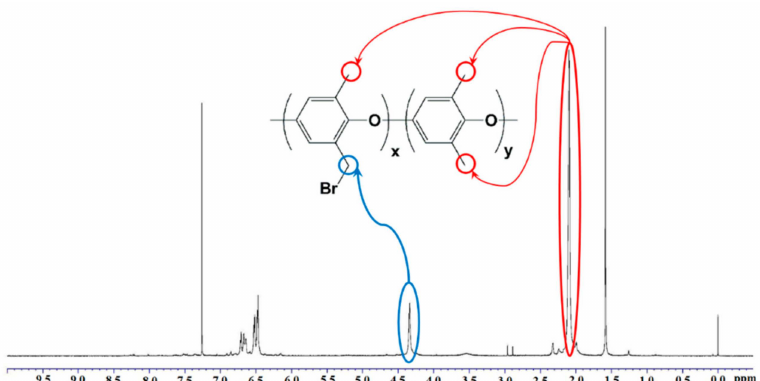
Figure 2. 1 HNMR spectra of BrPPO in CDCl 3 . The blue line indicates the characteristic peak of brominated methyl protons (–CH 2 Br). The red line indicates the characteristic peak of methyl (benzylic: –CH 3 ).